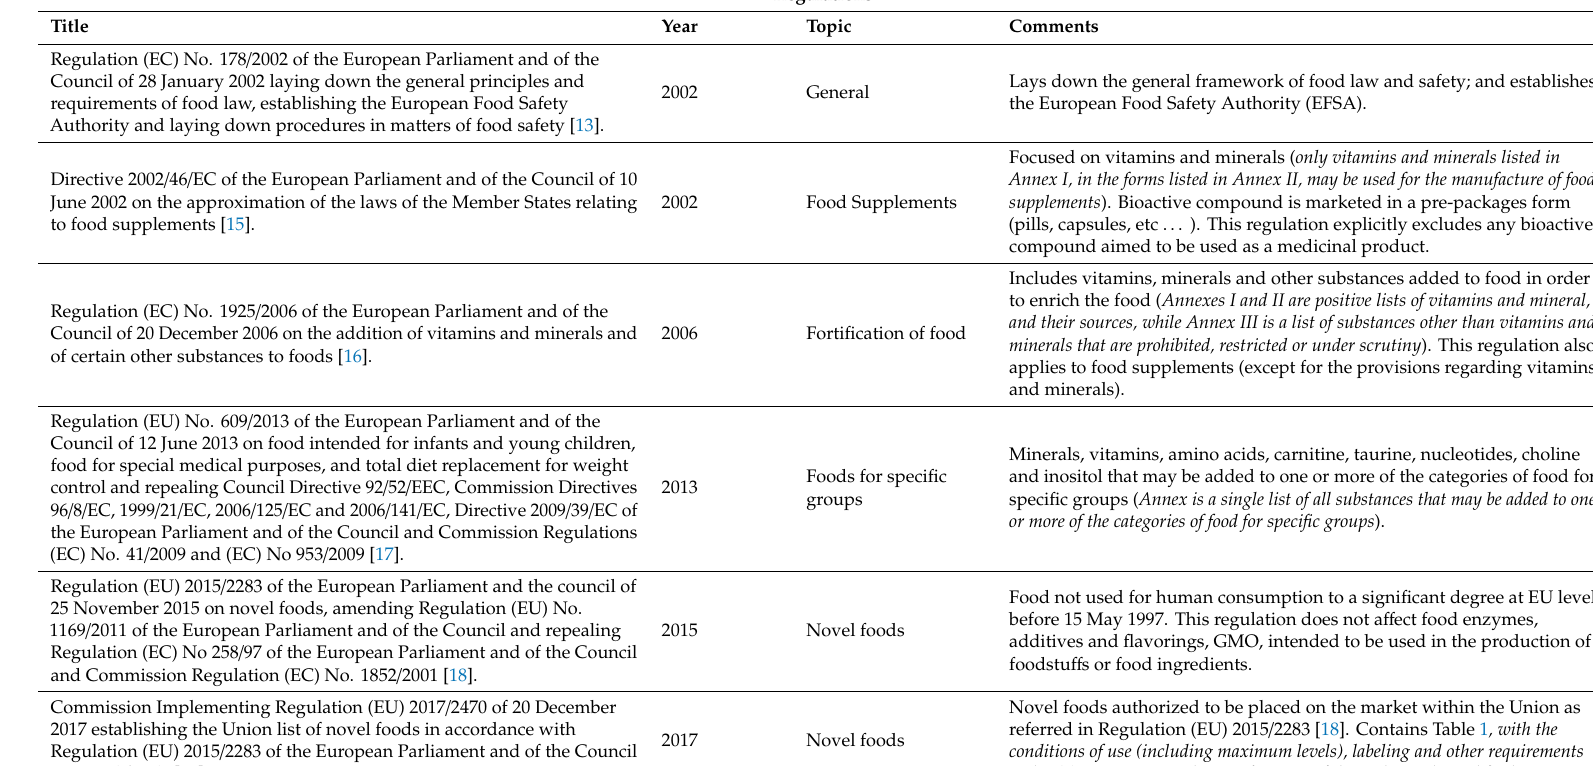
Table 2. European regulatory framework of food-related bioactive